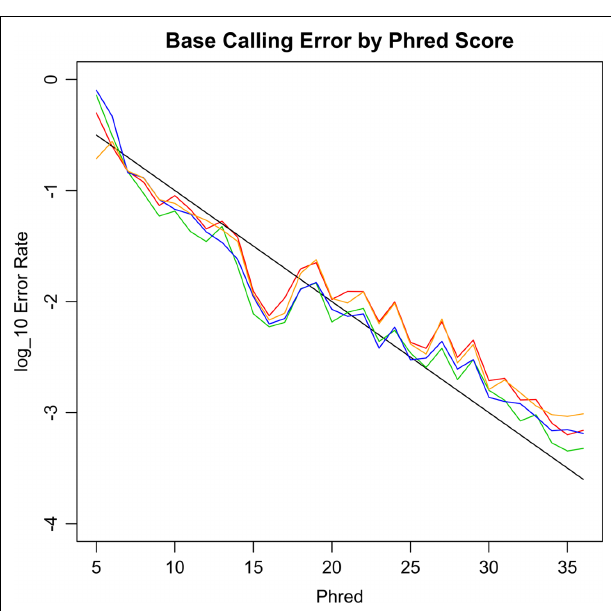
FIGURE 2 |The empirical base-calling error rates against Phred score. The black line is the theoretical error rate based on the Phred score, i.e., 10 ( − Phred/10) .The red, orange and blue and green lines are for A, C, G,T bases, respectively.The A andT bases have slightly higher error rates than those of C and G.